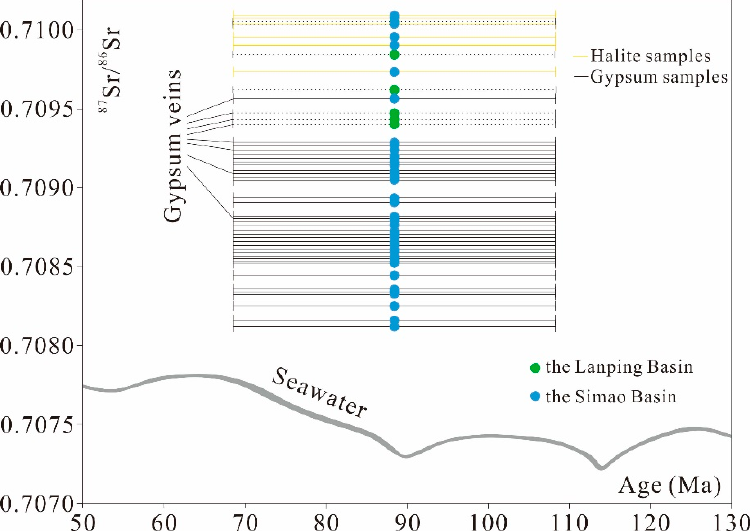
Figure 7. Comparison between 87 Sr/ 86 Sr ratios of evaporite minerals in Lanping–Simao Basin and contemporaneous seawater (data from [22]).